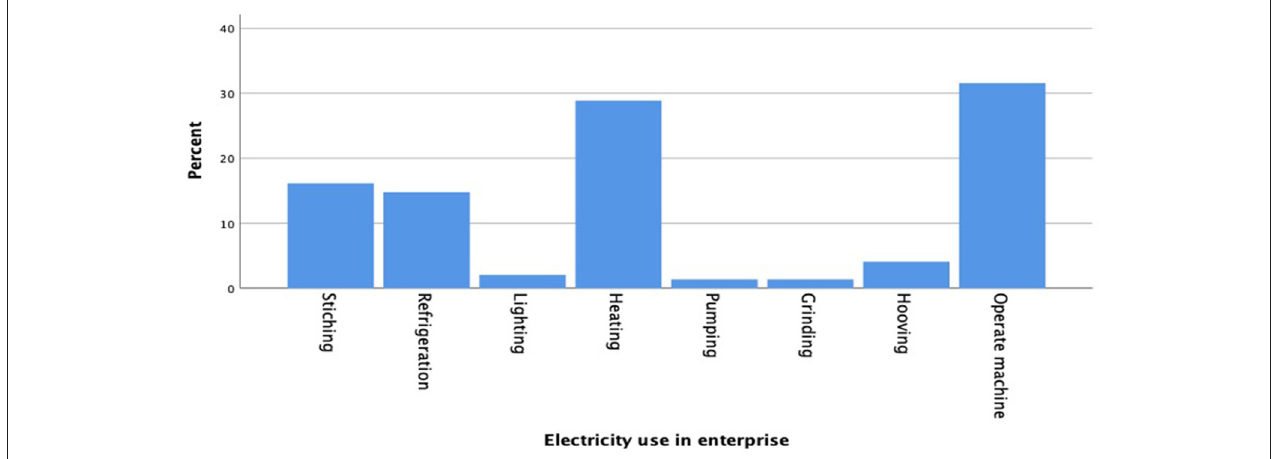
FIGURE 6 | Different electricity uses in the enterprise. Source: Field survey (2018).